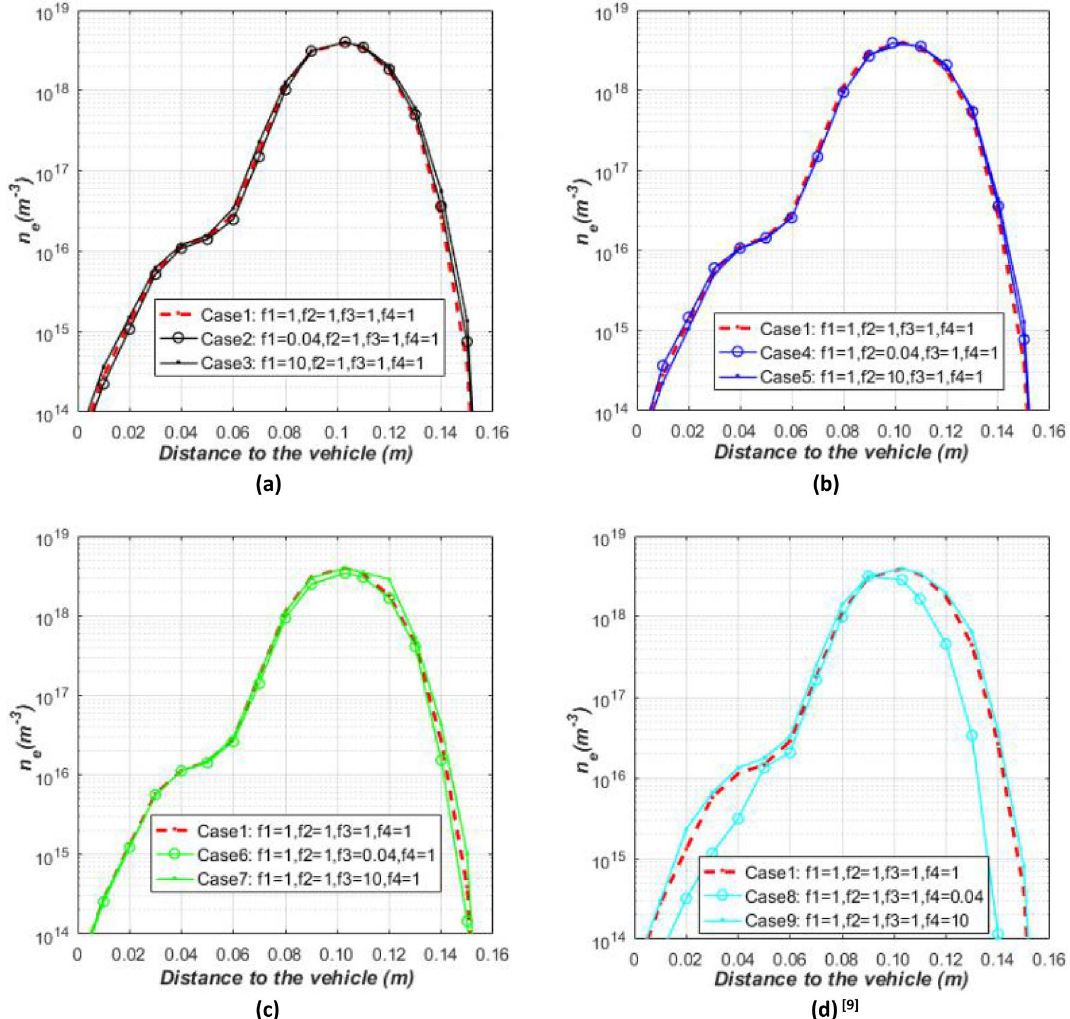
Figure 6. Influence of different non-ionization reaction rates on the electron number density and the comparison with the influence of ionization reaction rate. ( a ) Reaction rate of N 2 ⇋ N + N , ( b ) reaction rate of O 2 ⇋ O + O , ( c ) reaction rate of NO ⇋ N + O and ( d ) reaction rate of N + O ⇋ NO + + e